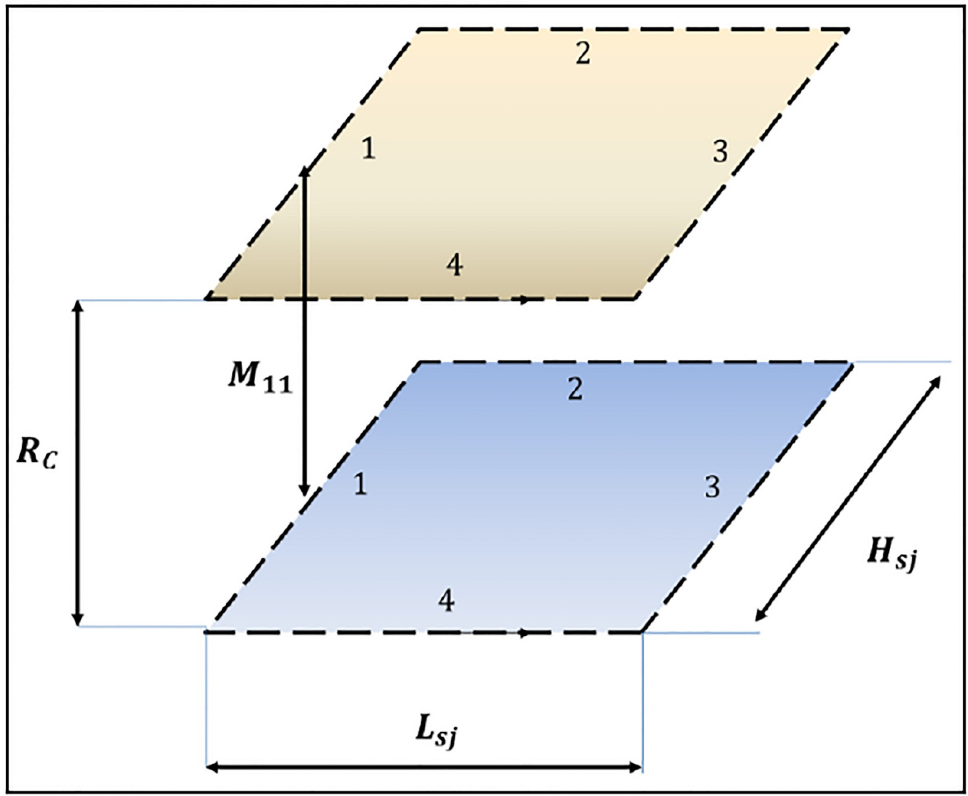
Fig 7. Geometry to calculate the mutual inductance between two parallel and coaxial rectangular loops with the same dimensions. coaxial loops separated by a distance equal to the radius of the conductor R